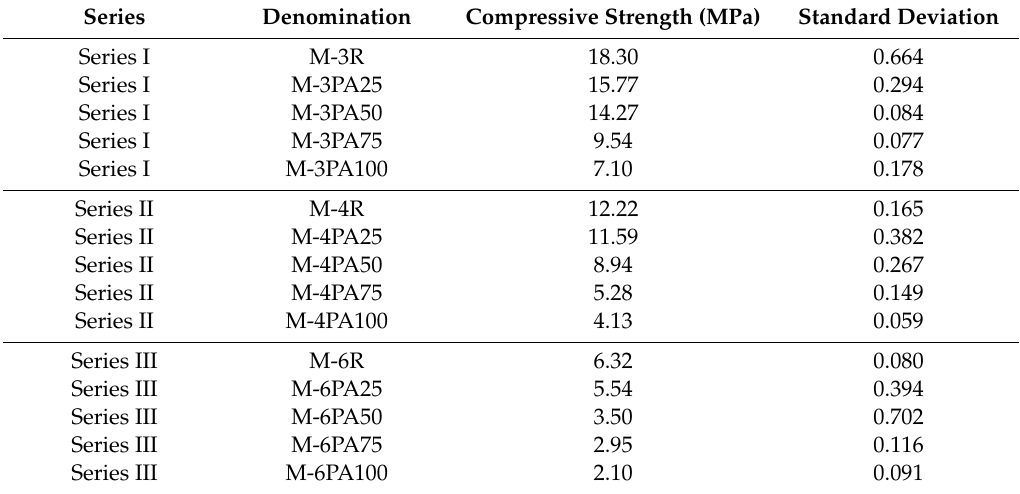
Table 11. Average compressive strength of each mortar